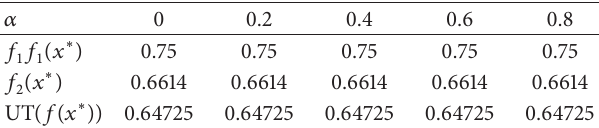
Table 12: The efficient points of the subproblems according to different values of 𝛼 for Example 3.